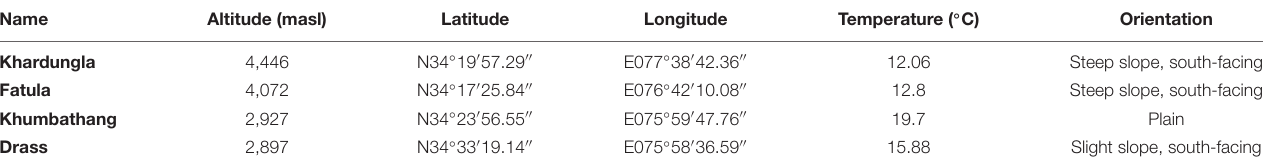
TABLE 1 | Study sites in the Ladakh region (average temperature as measured during sample